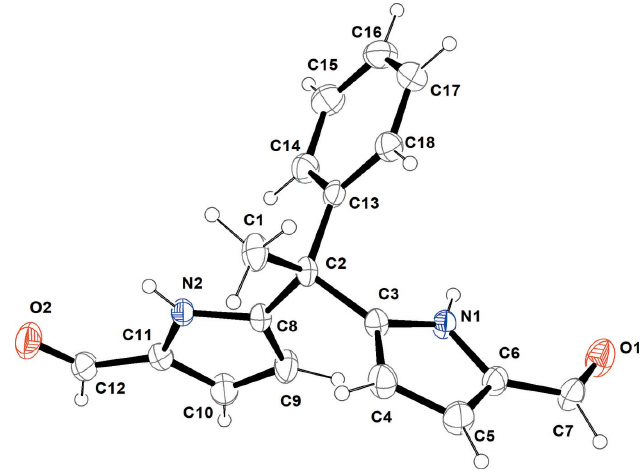
Figure 1 The molecular structure of the title compound with displacement ellipsoids drawn at the 30% probability level.